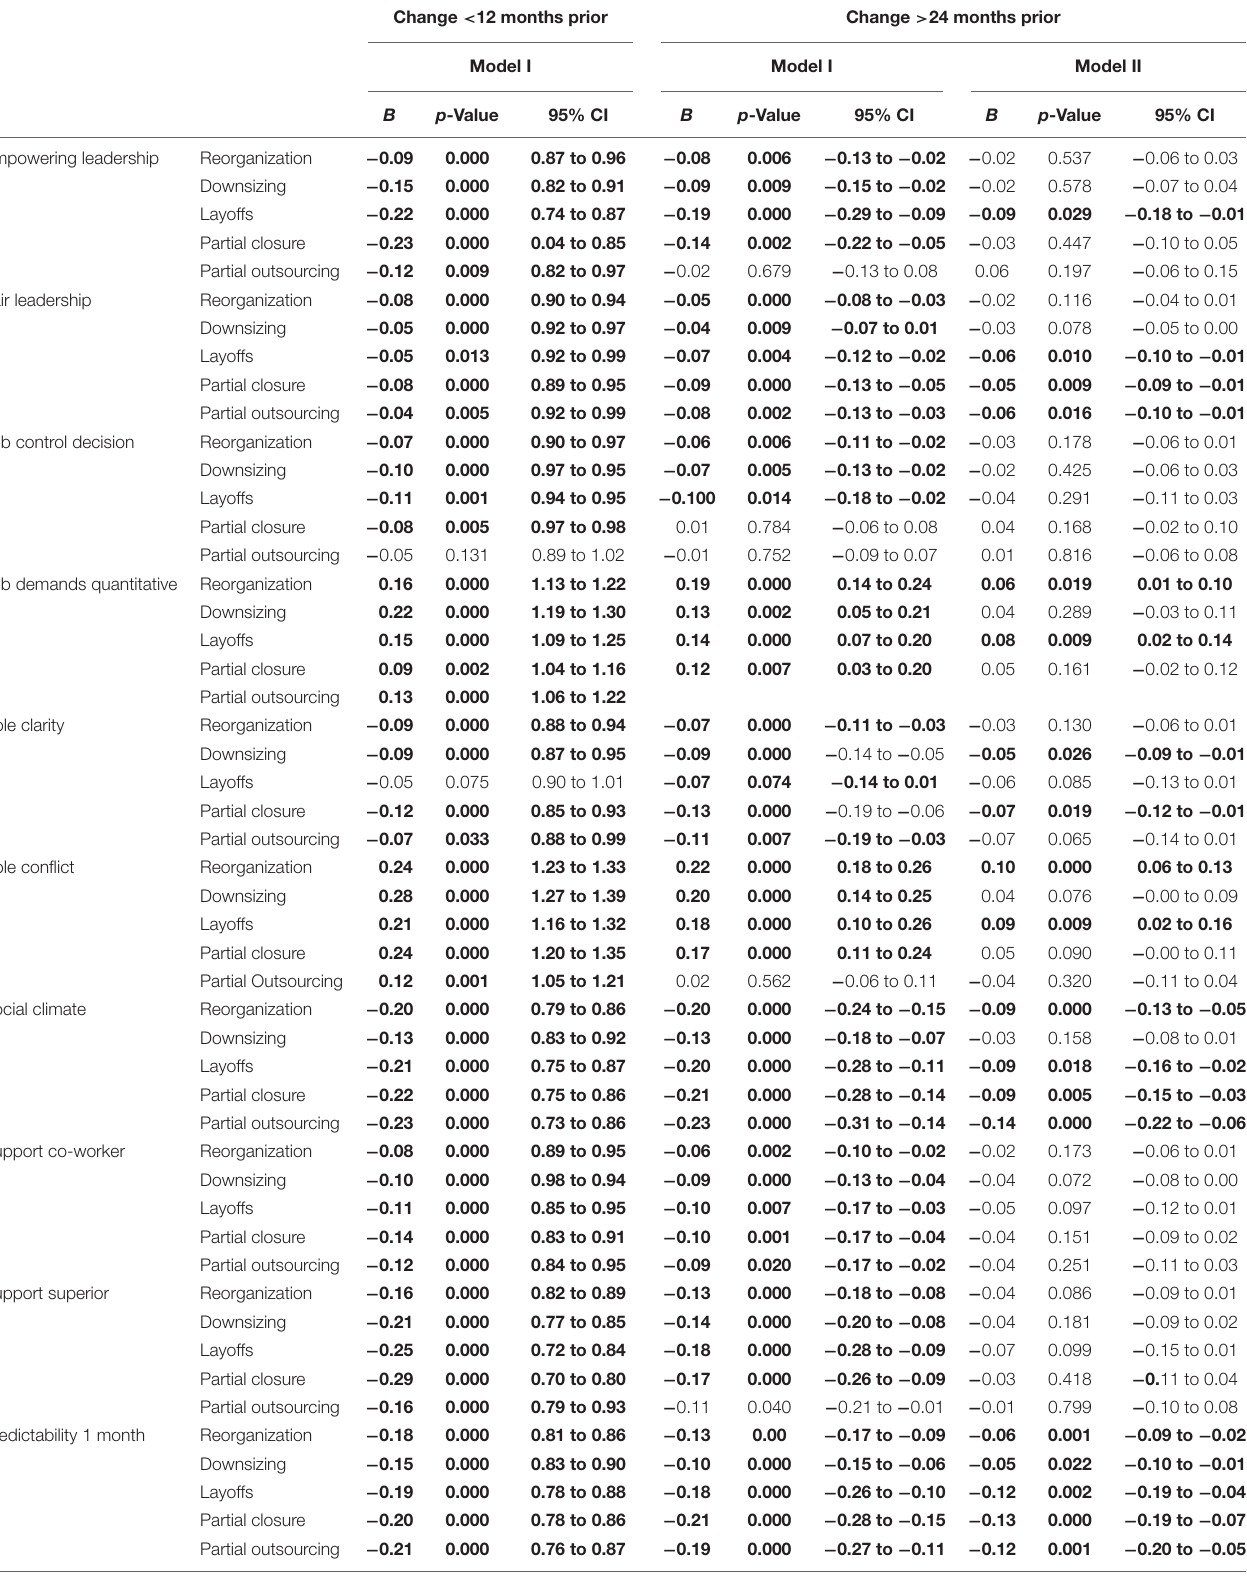
TABLE 4 | Separate organizational